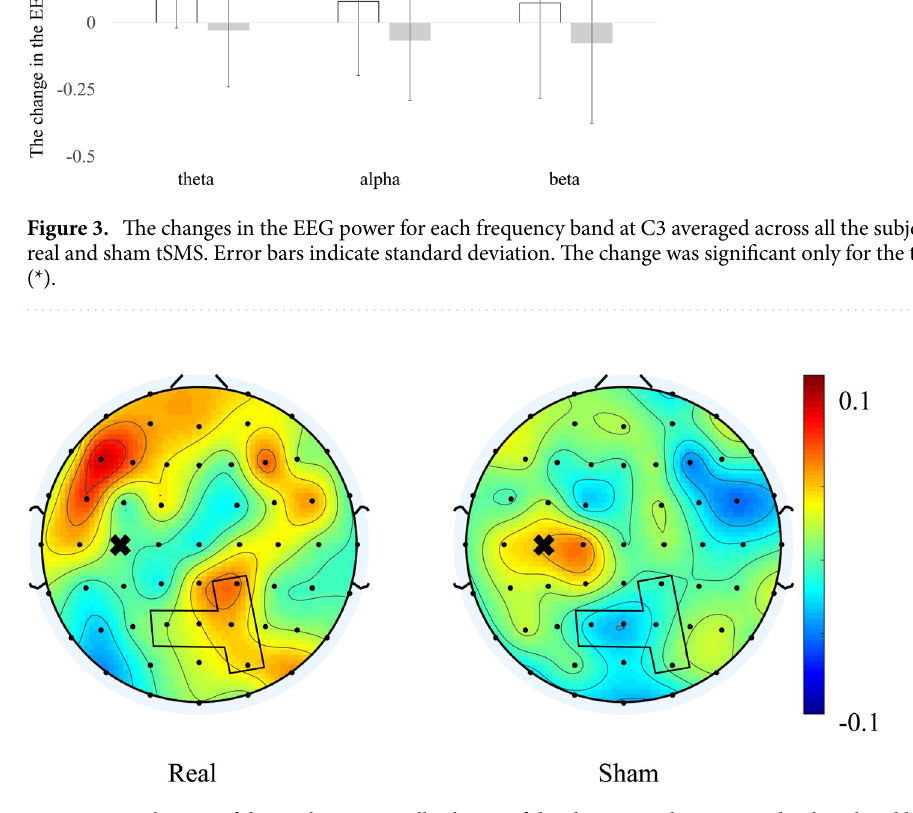
Figure 4. Scalp map of the median across all subjects of the changes in the wPLI in the theta band between C3 and the other electrodes for real (left) and sham (right) tSMS. A cross mark shows the position of C3. The significant cluster was identified at the electrodes surrounded by a black